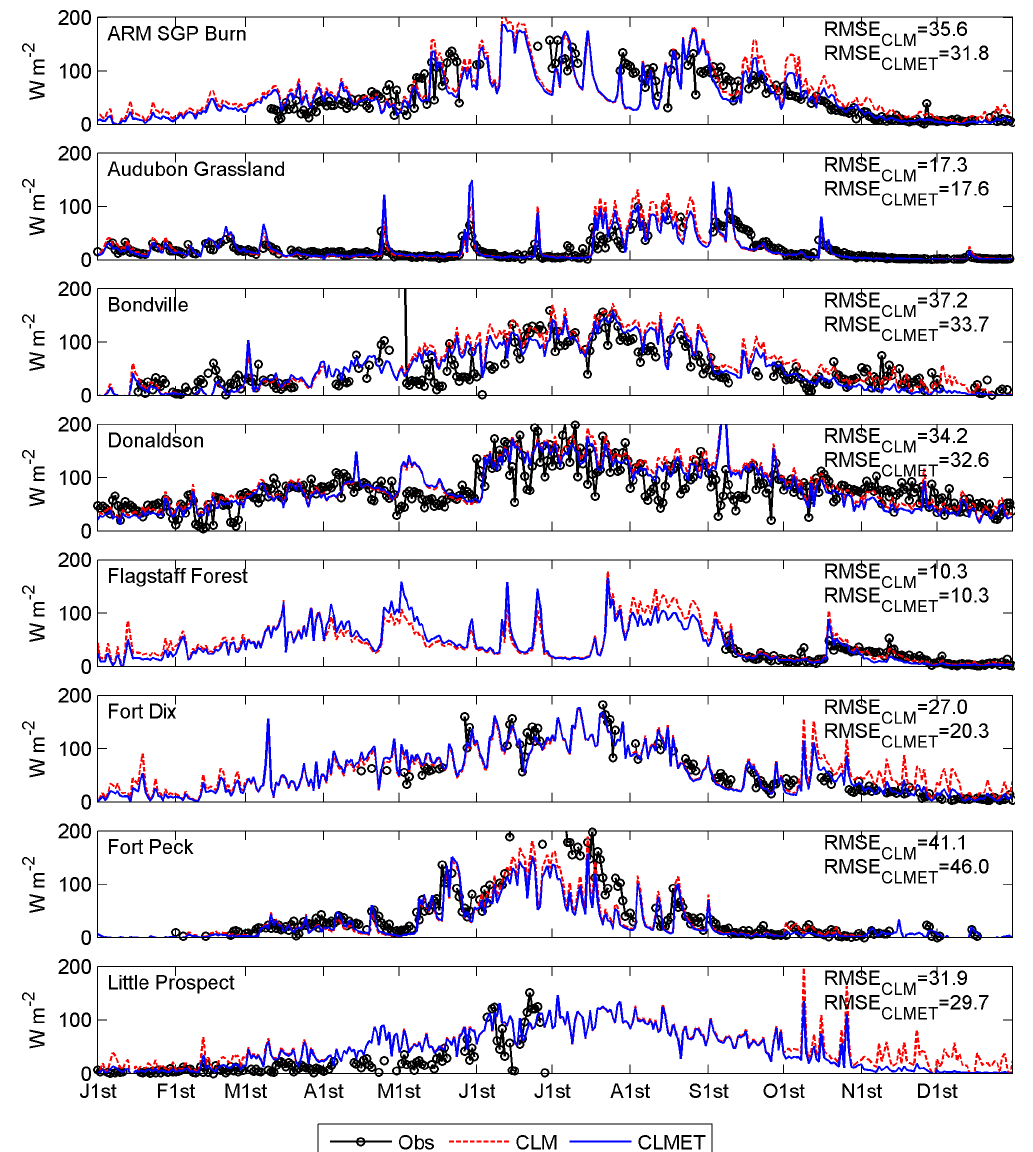
Figure 9. Daily mean latent heat fluxes from the CLM and CLMET grids and station observations at ARM SGP Burn, Audubon Grassland, Bondville, Donaldson, Flagstaff Forest, Fort Dix, Fort Peck, and Little Prospect. RMSE CLM and RMSE CLMET represent the root mean square error against observations for the CLM and CLMET,